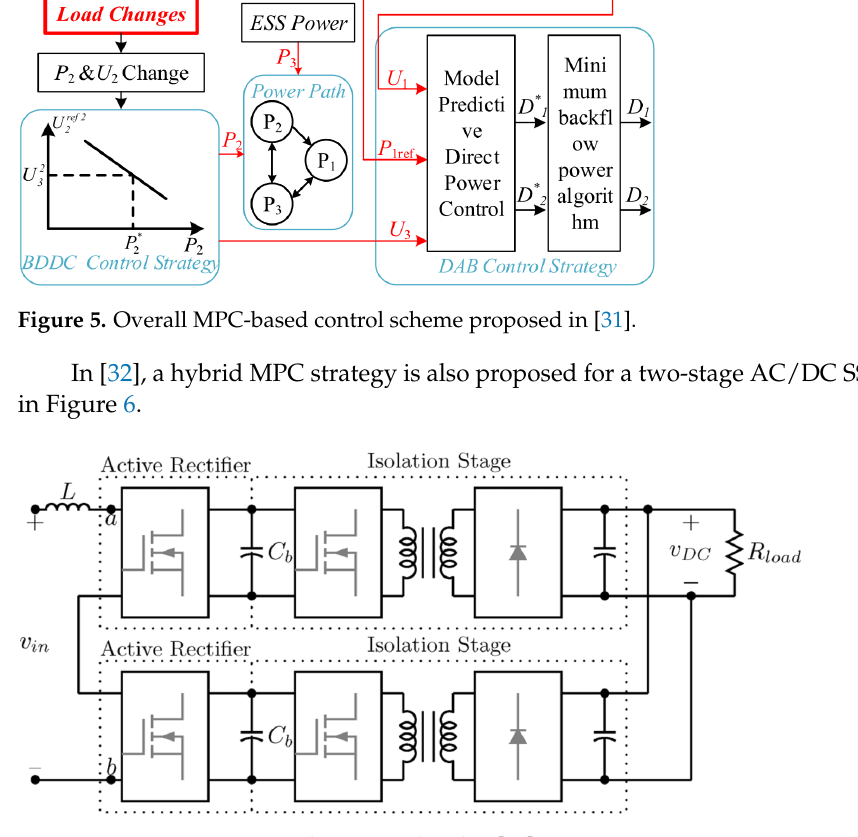
Figure 6. Two-stage SST topology considered in